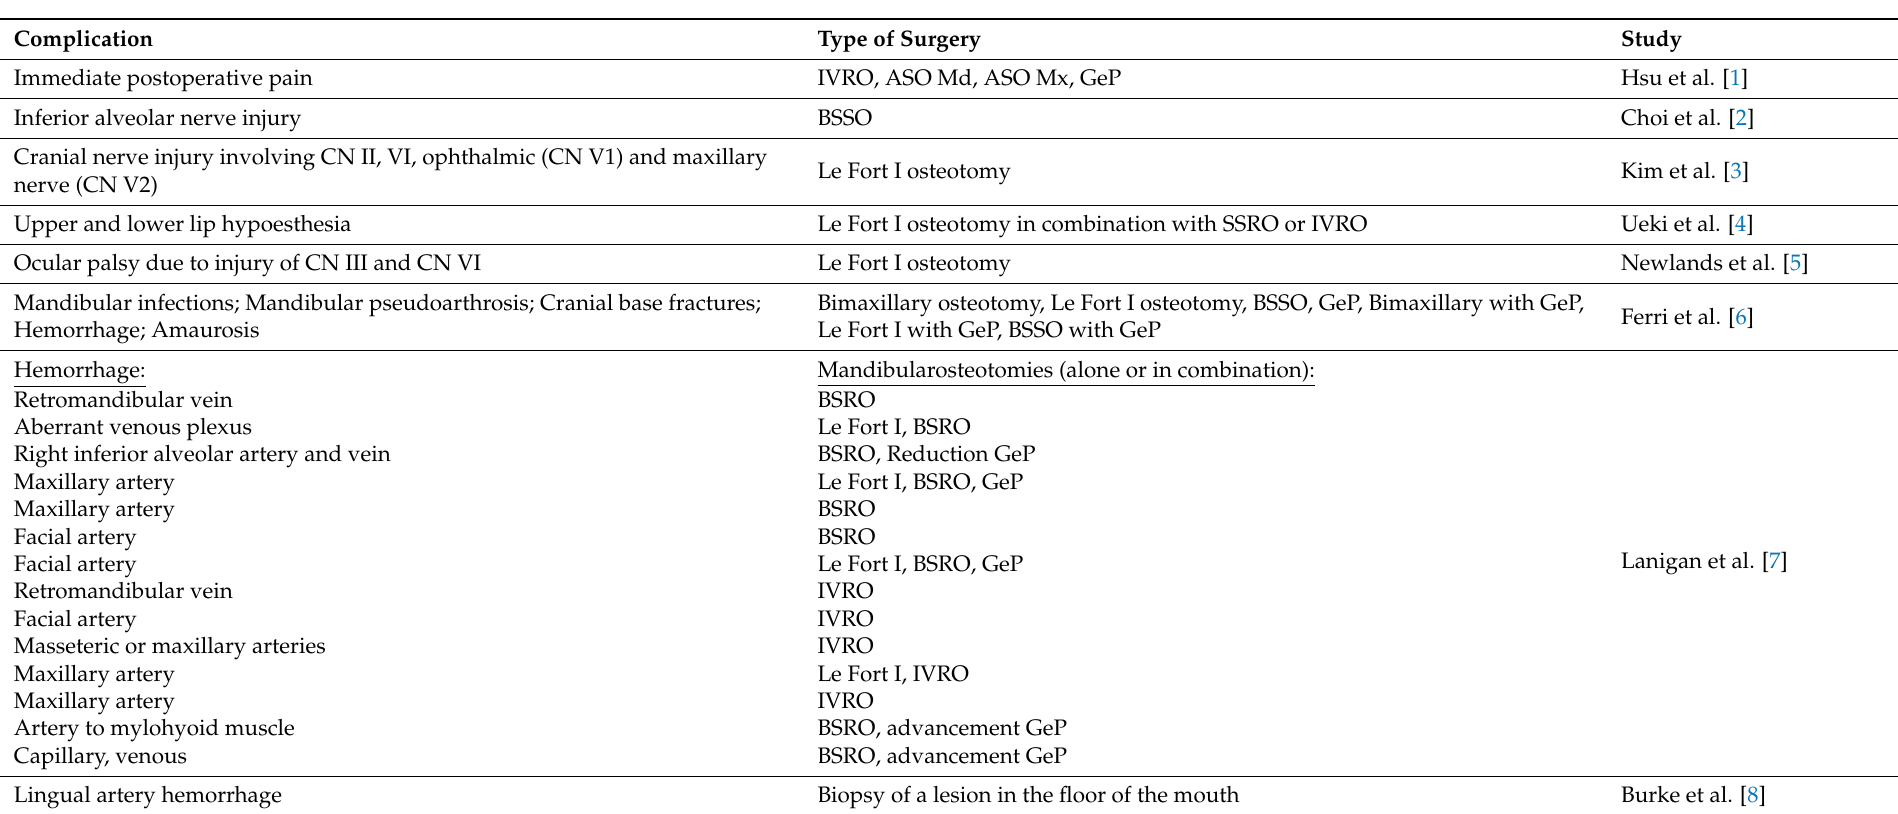
Table 1. Possible complications during and after Orthognathic surgeries and other intraoral procedures. Intraoral vertical ramus osteotomy (IVRO), anterior segmental osteotomy of the mandible (ASO Md), anterior segmental osteotomy of the maxilla (ASO Mx), genioplasty (GeP), bilateral sagittal split osteotomy